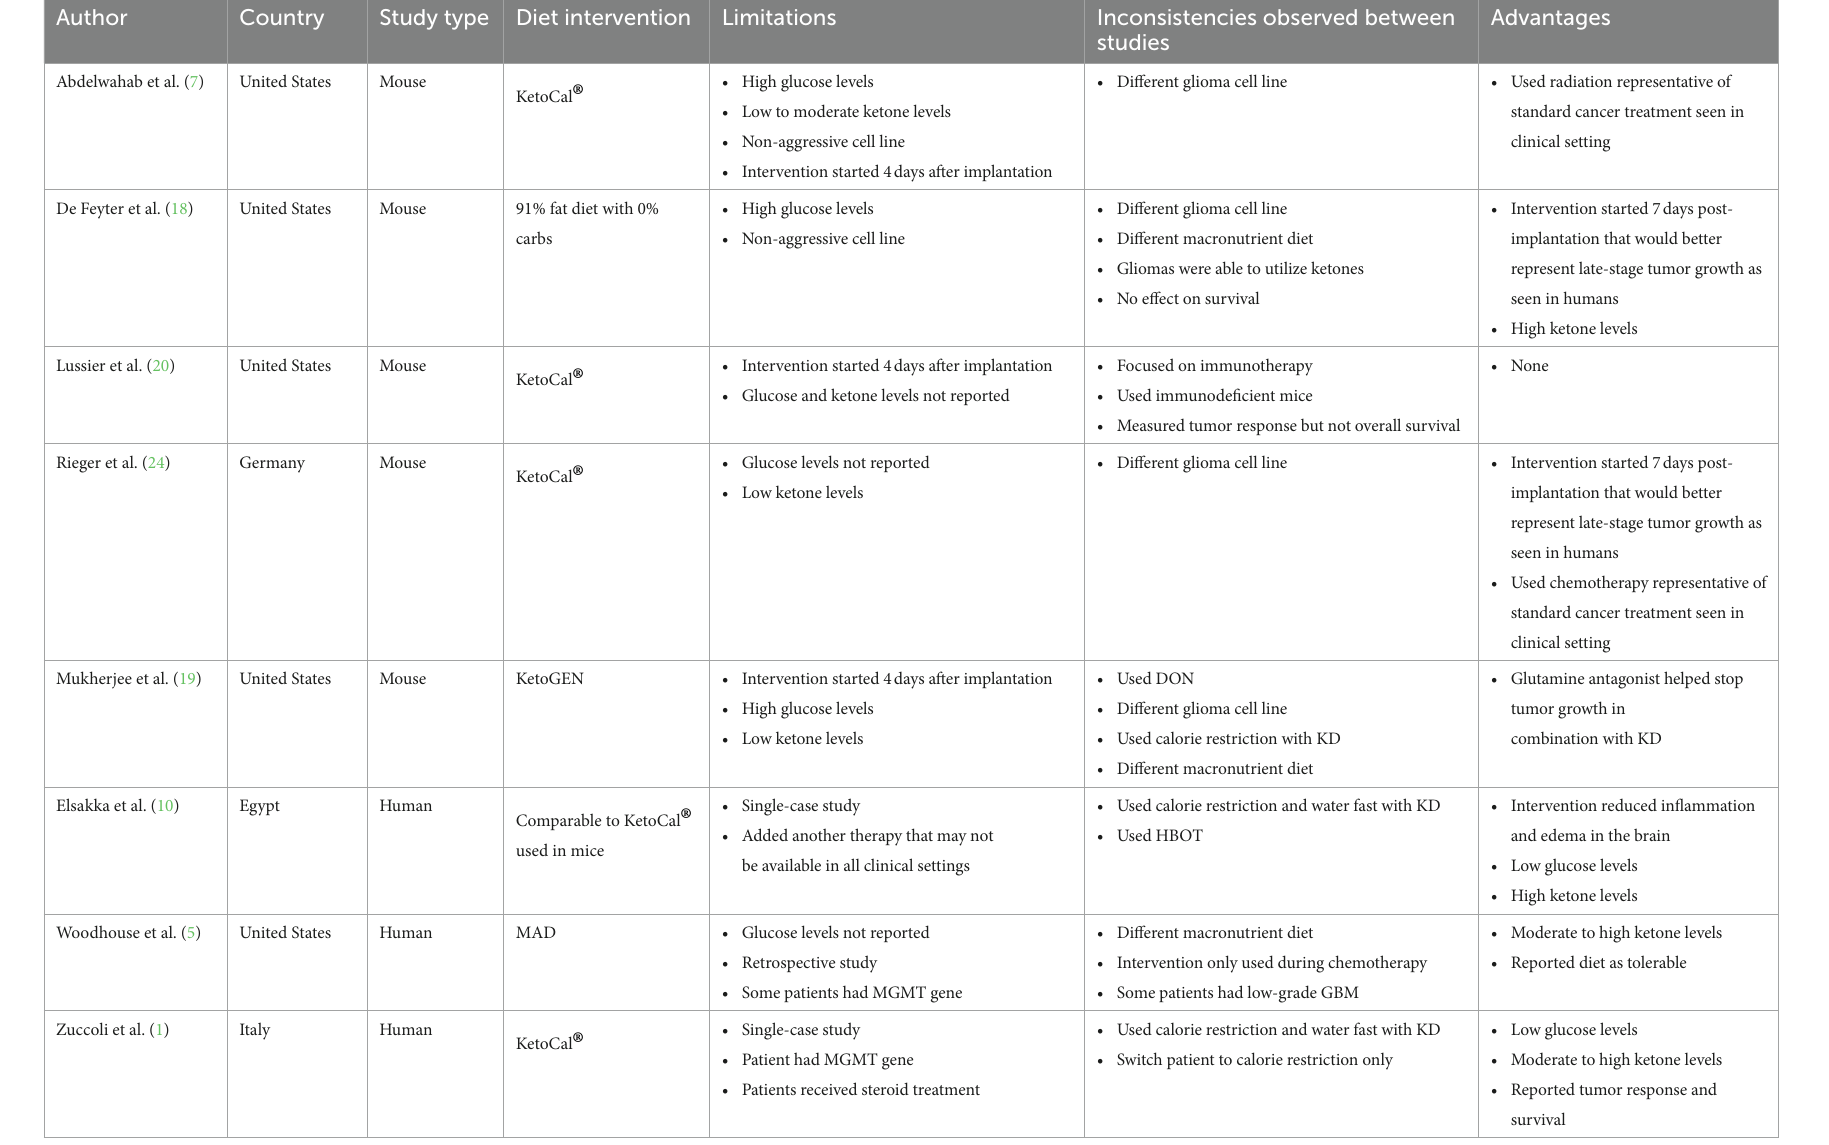
TABLE 2 Summary of Limitations and Inconsistencies Between Pre-Clinical and Clinical Research Treating